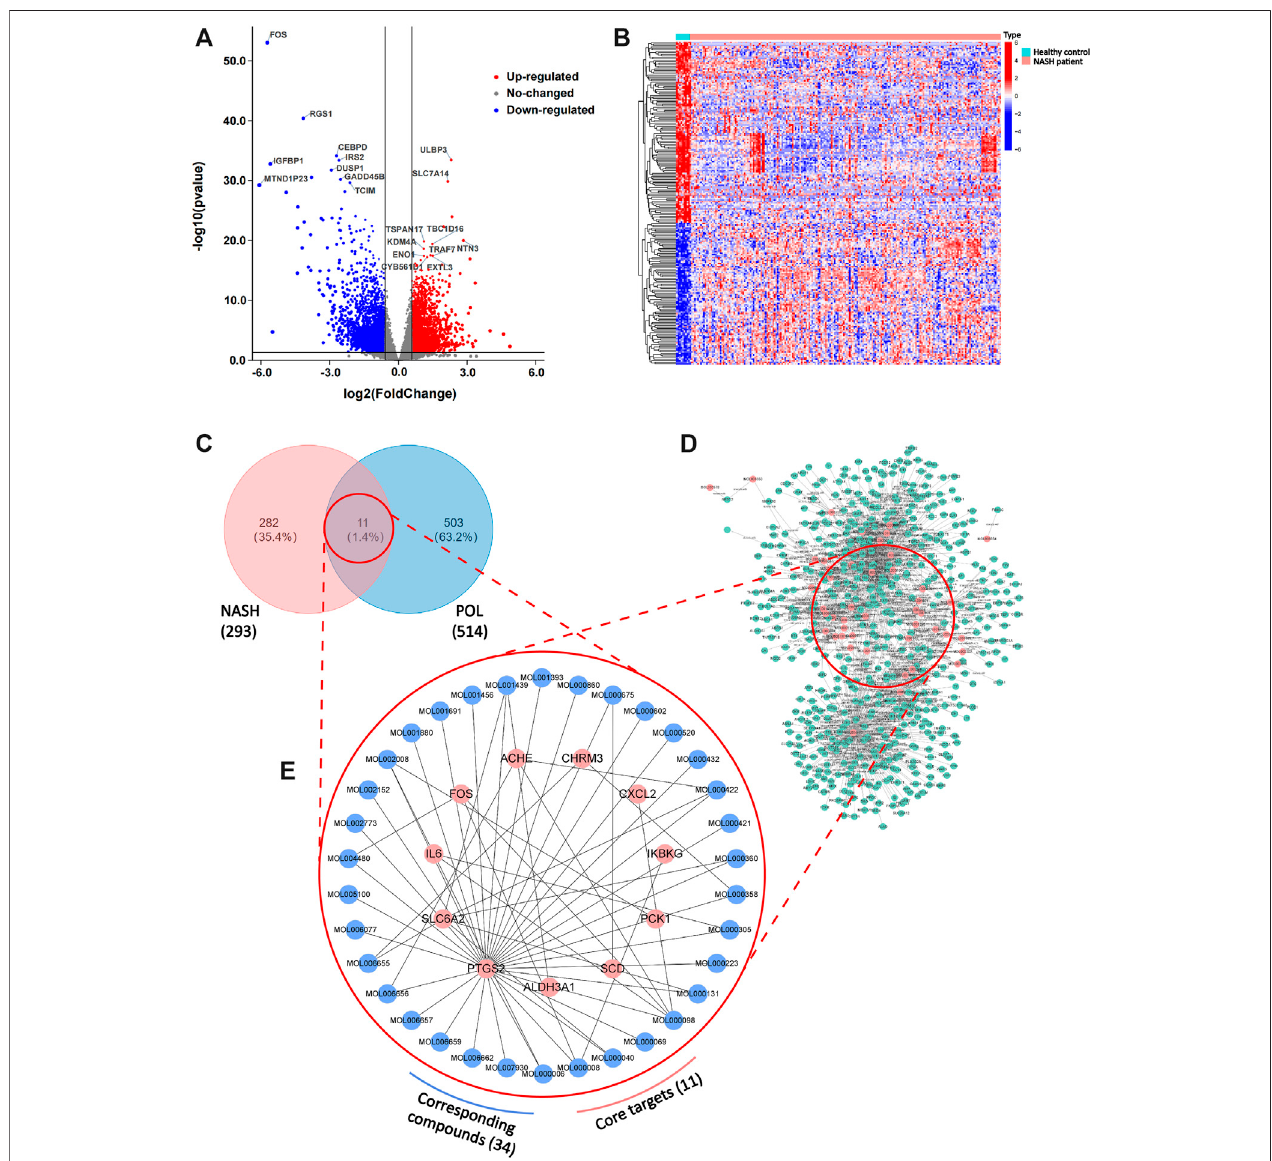
FIGURE3| DEGsinpatientswithNASHandhealthypeopleandtheintersectedgenesofDEGsandpredictedtargets.Thedataset(GSE135251)wasdownloaded from GEO Datasets. Then, DEGs were calculated by limma package and plotted by R. Volcano plot of DEGs (A) and heatmap plot of DEGs (B) were graphed and red dots represented up-regulated genes while blue represented down-regulated genes. Top ten up-regulated and down-regulated genes were labeled. Then, predicted targets of POL (D) were obtained from TCMSP database. The intersected genes (N&P) of DEGs and predicted targets (C) were graphed by Venn diagram. The network of corresponding compounds and core genes (N&P) (E) was graphed by Cytoscape. Blue circles represented constitutes of POL while red represented core genes (N&P).